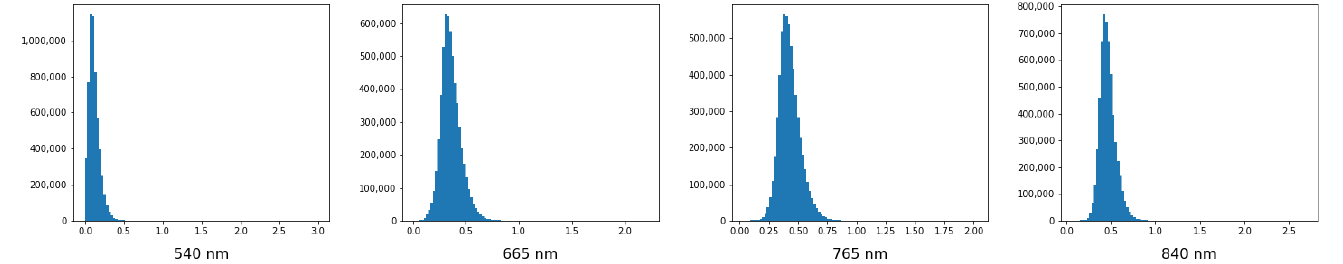
Figure 11. Probability distribution of some of the wavelengths. 4.